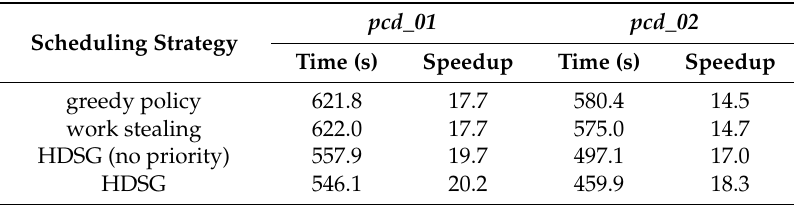
Table 7. Interpolation time (s) and speedups of the hybrid parallel algorithm with different scheduling strategies on hpc_01.